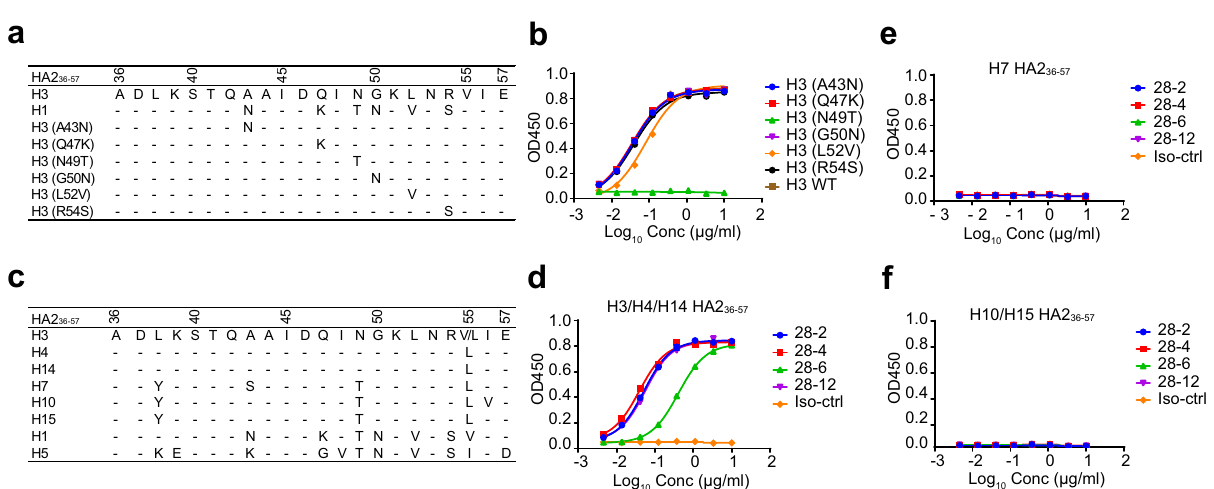
Fig. 5 N49 HA2 is critical for the recognition of H3 epitope features by V H 3-48/V K 1-12 lineage antibodies. a Sequence alignment of the conserved epitope 36-57 HA2 of H1 and H3 . b Dose-dependent binding of 28-12 to divergent mutants of H3 peptide 36-57 HA2 compared with the wild-type peptide. c Sequence alignment of 36-57 HA2 within multiple subtypes. H3/H4/H14, but not other subtypes have residue N in position 49 HA2 . d – f Dose-dependent reactivity of the V H 3-48/VK1-12 lineage antibodies to peptide 36-57 HA2 of multiple subtypes. 8D6 was included as the isotype control. Data are presented as mean values of duplicates ( b , d , e , f ). Representative data are shown from two independent experiments ( b , d , e , f